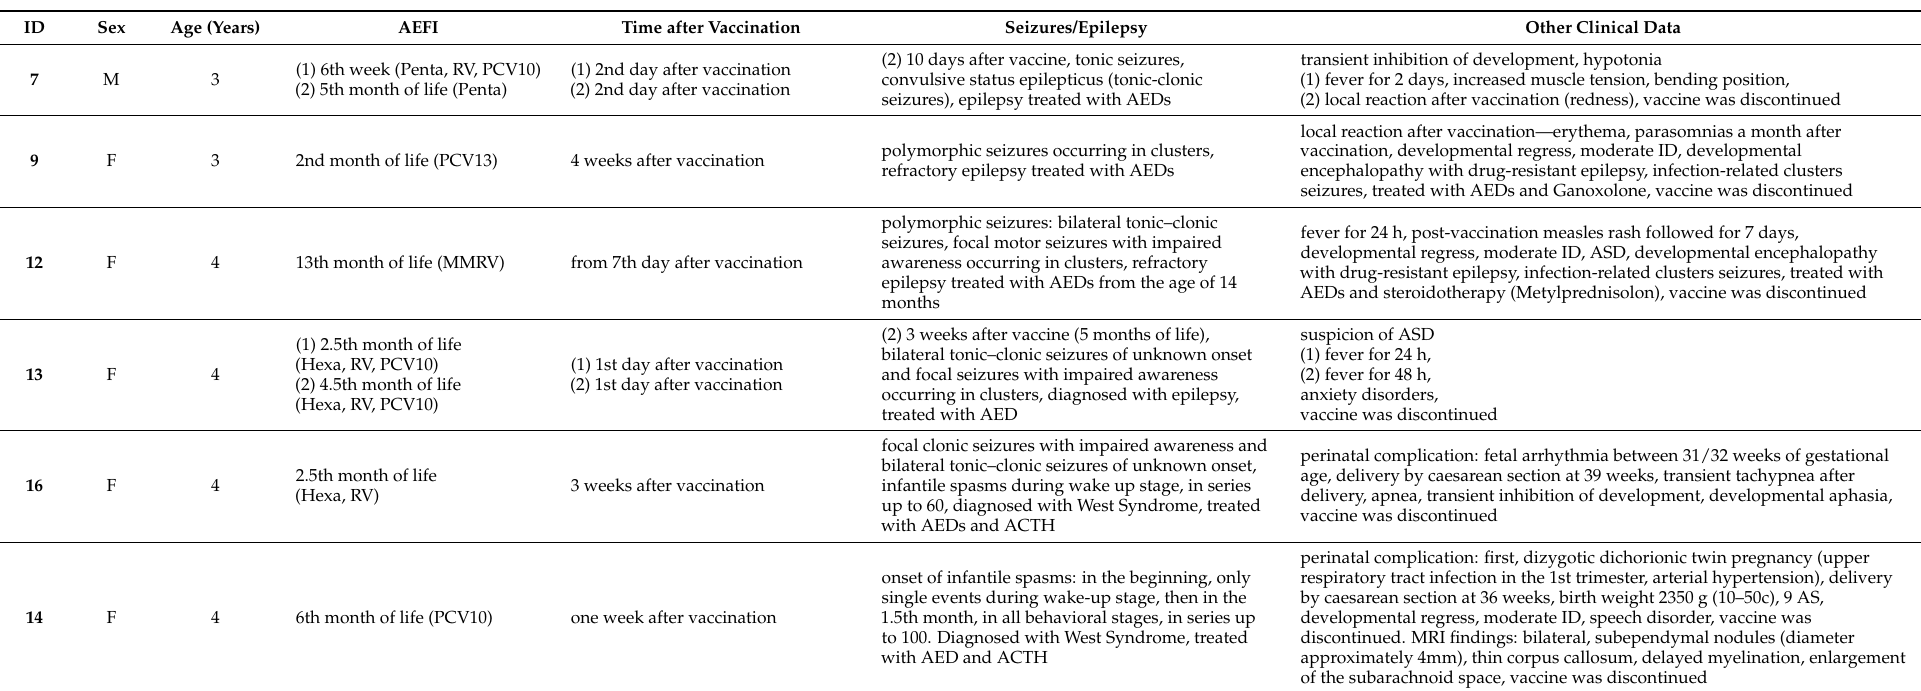
Table 2. Adverse events following immunization (AEFI) in patients from the study cohort who were diagnosed with pathogenic/likely pathogenic variants